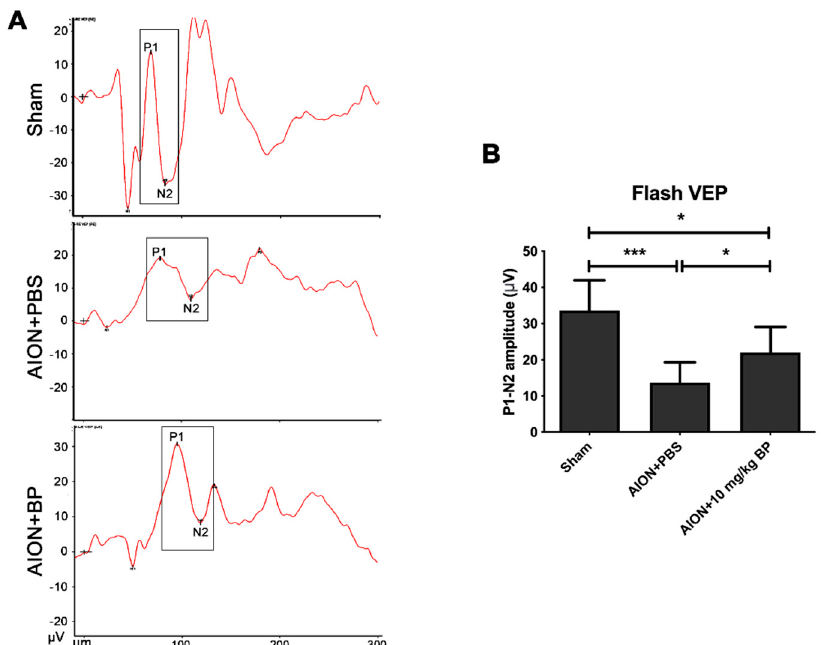
Figure 2. The amplitudes were recorded by FVEPs to evaluate the visual function. The images of electric potential in each group were shown in ( A ). Quantitative graphs of P1-N2 amplitudes in the sham, PBS-treated, and BP-treated groups were 33.63 ± 8.30 μ V, 13.70 ± 5.59 μ V, and 22.01 ± 7.03 μ V, respectively ( B ). (***, p ≤ 0.001; *, p ≤ 0.05; n = 6.)